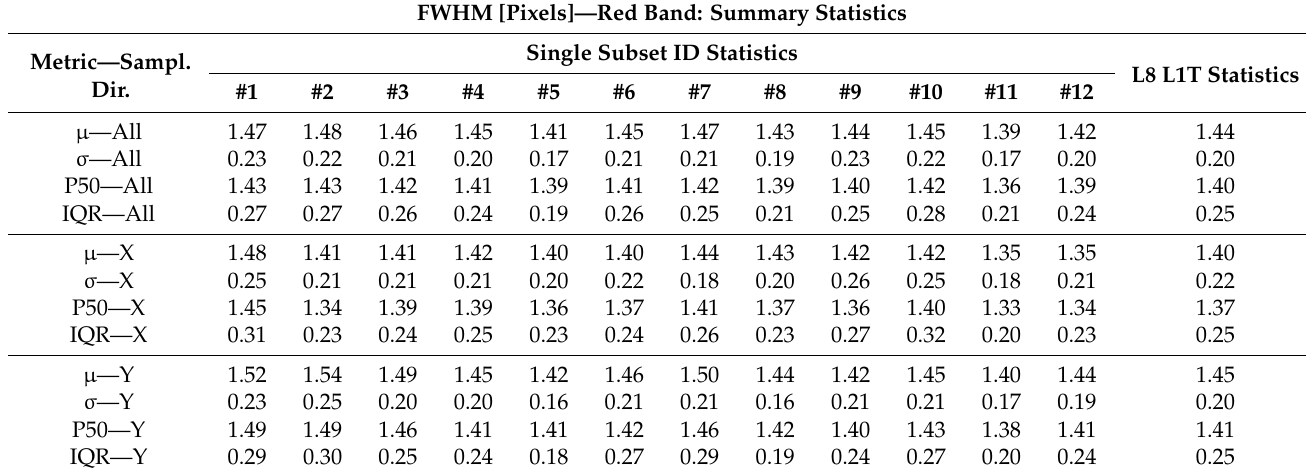
Table 6. SaSbEM validation results for the red band.